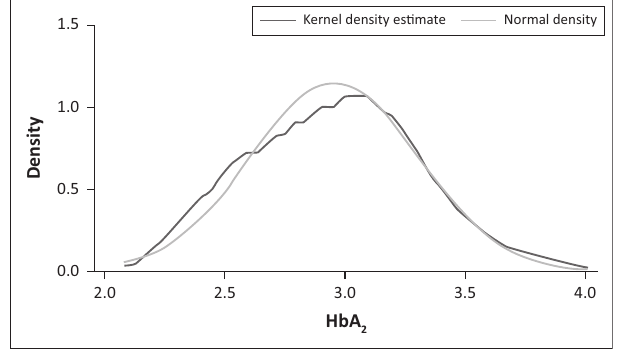
distribution, Pretoria, South Africa, 01 2